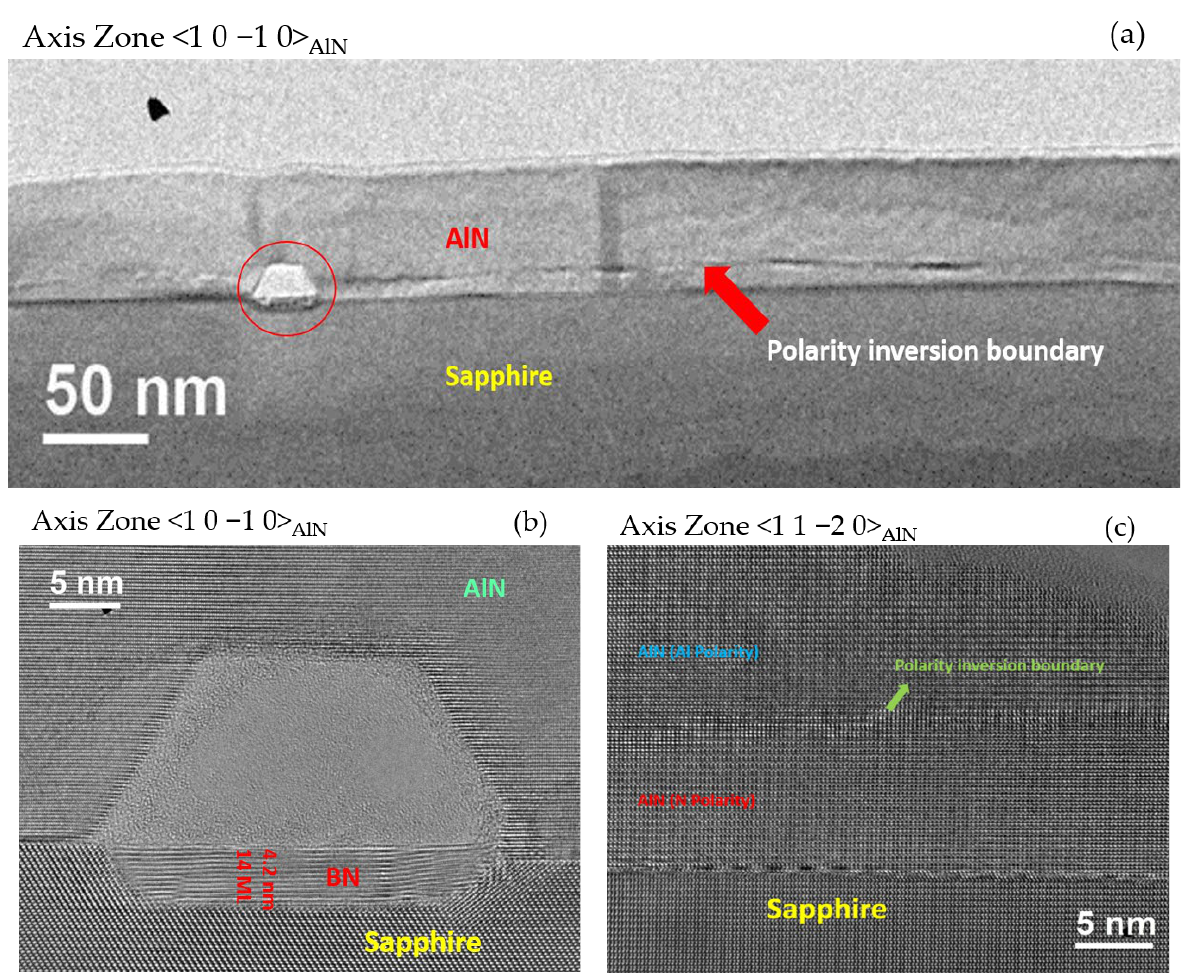
Figure 7. Multibeam cross-sectional TEM images of sample A (50 nm AlN) along the <1 0 −1 0> and <1 1 −2 0> AlN zone axes. ( a ) Low-resolution image of AlN on h-BN showing a cavity at the interface with the sapphire substrate. In addition, a polarity inversion boundary is shown close to the interface (~10 nm above it). ( b ) High-resolution image of the cavity observed in ( a ), where h-BN inclusion in the sapphire zone can be observed. ( c ) High-resolution image of the interface between sapphire and AlN, where h-BN has completely disappeared from the interface with sapphire. In addition, the polarity inversion boundary can be observed with N-polar AlN underneath it and Al-polar AlN above